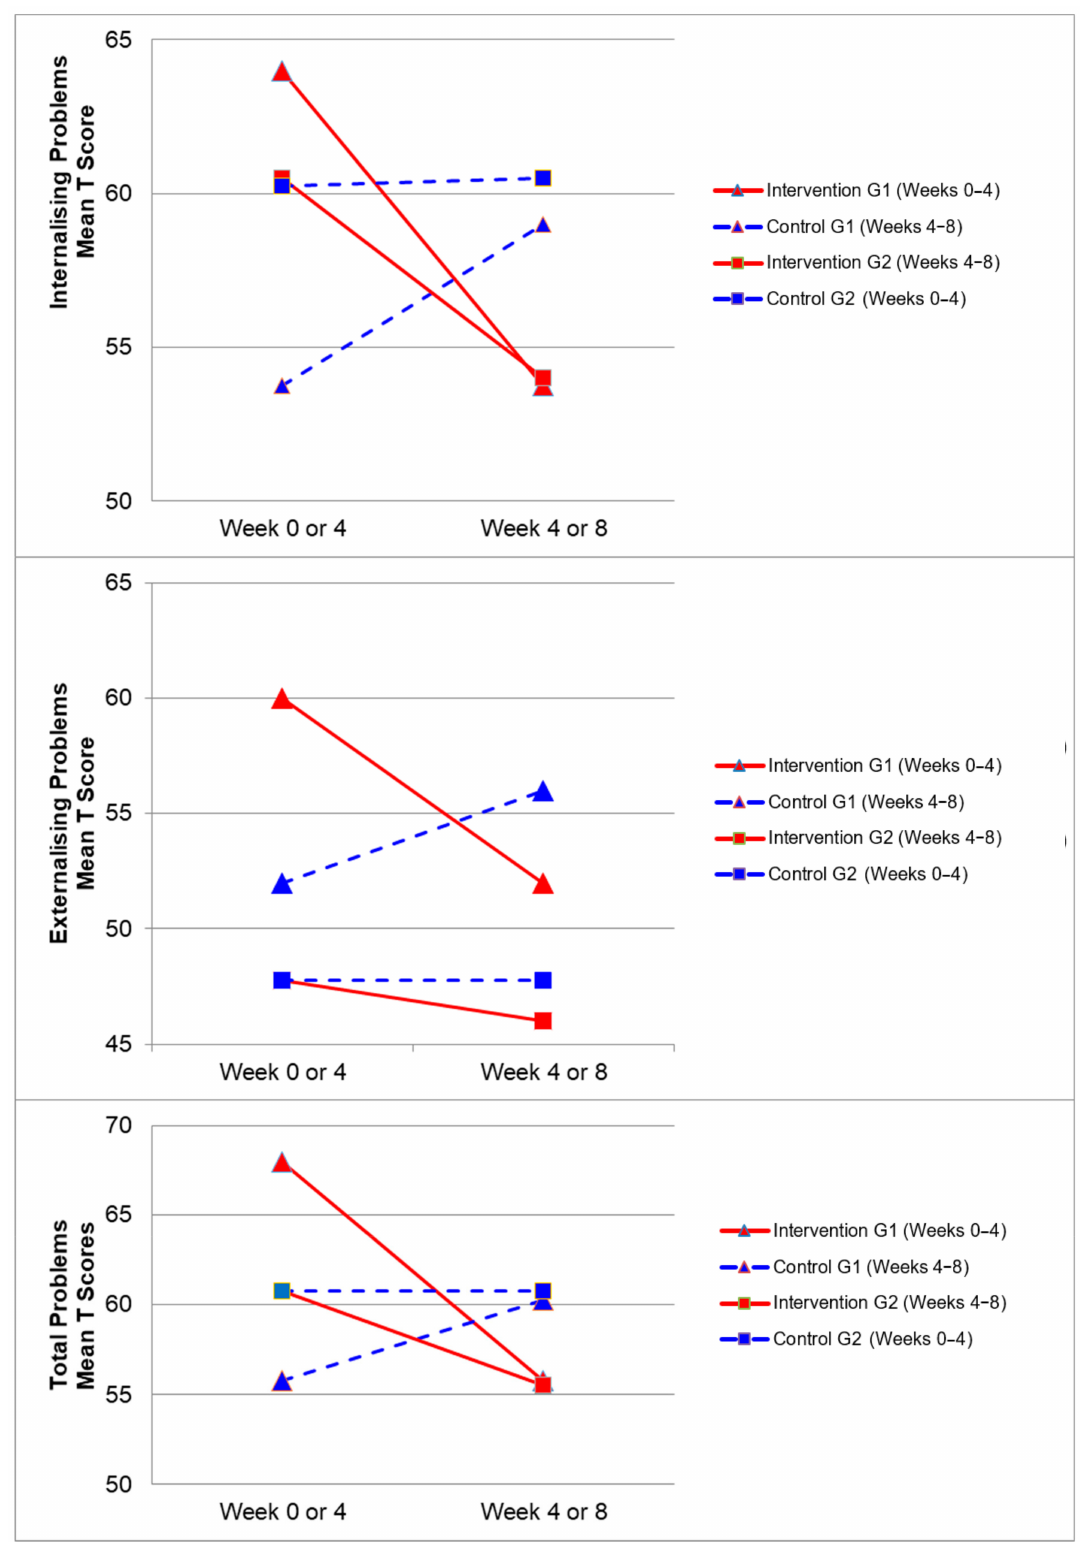
Figure 5. Mean t score changes within Group 1 (G1) and Group 2 (G2) based on intervention vs. control periods for the internalizing problems, externalizing problems, and total